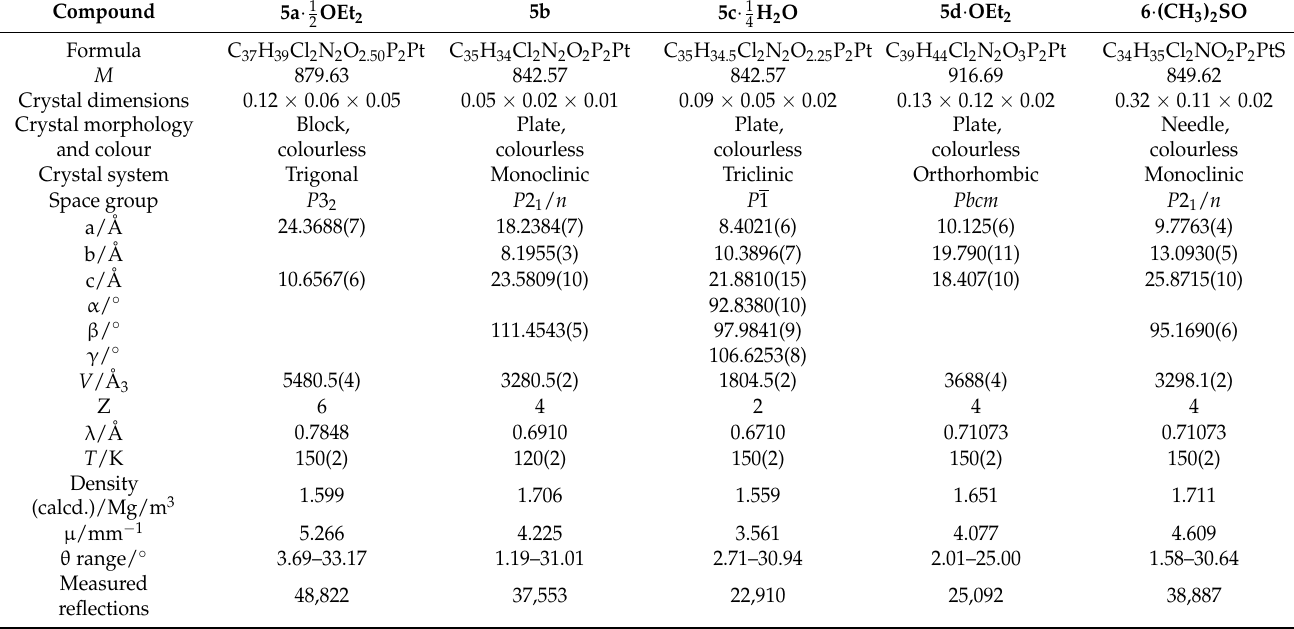
OEt 2 , 5b , 5c · 1 2